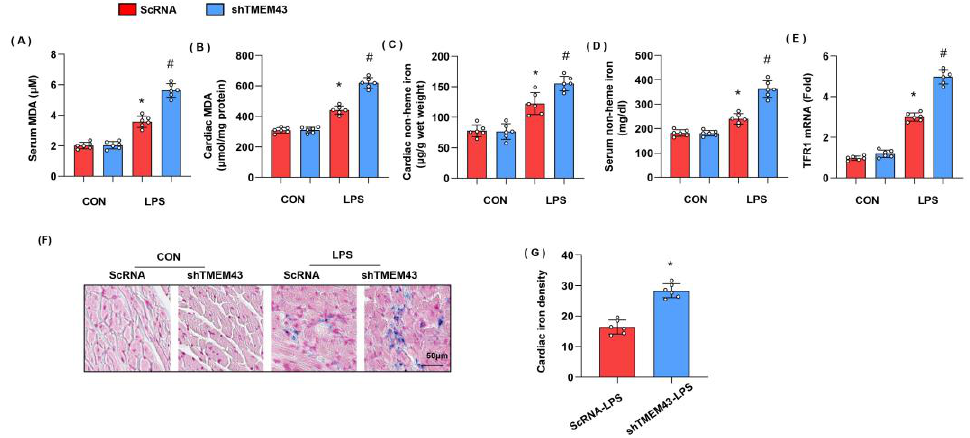
Figure 4. TMEM43 knockdown aggravates LPS-induced ferroptosis. ( A , B ) Serum and cardiac MDA level in mice injected with shTMEM43 under LPS challenge ( n = 6). ( C , D ) Serum and cardiac non-heme iron in mice injected with shTMEM43 under LPS challenge ( n = 6). ( E ) mRNA level of TFR1 in mouse hearts ( n = 6). ( F , G ) Prussian blue staining and quantified results in mice injected with shTMEM43 under LPS challenge ( n = 6). * p < 0.05 vs. scRNA/CON group. # p < 0.05 vs. scRNA/LPS group.